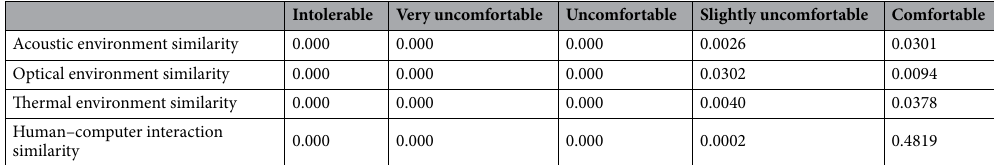
Table 4. Similarity between each index evaluation cloud and standard evaluation